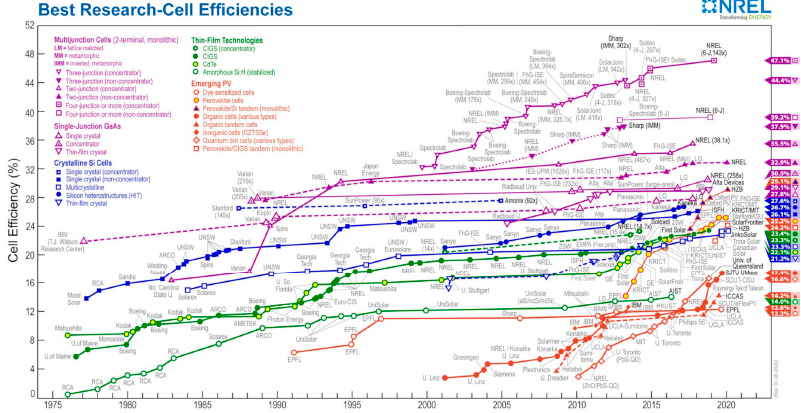
Figure 30. NREL chart of highest confirmed conversion efficiencies for research PV cells (courtesy of the National Renewable Energy Laboratory, Golden, Co. [183]).